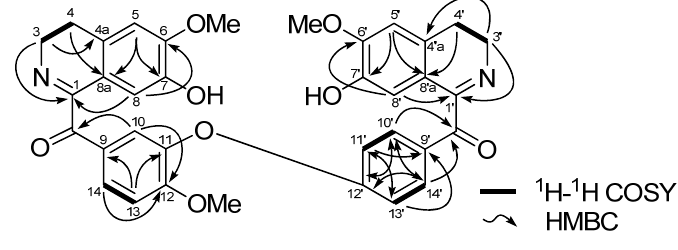
Figure 2. Selected 2D NMR correlations of lancifoliaine ( 1